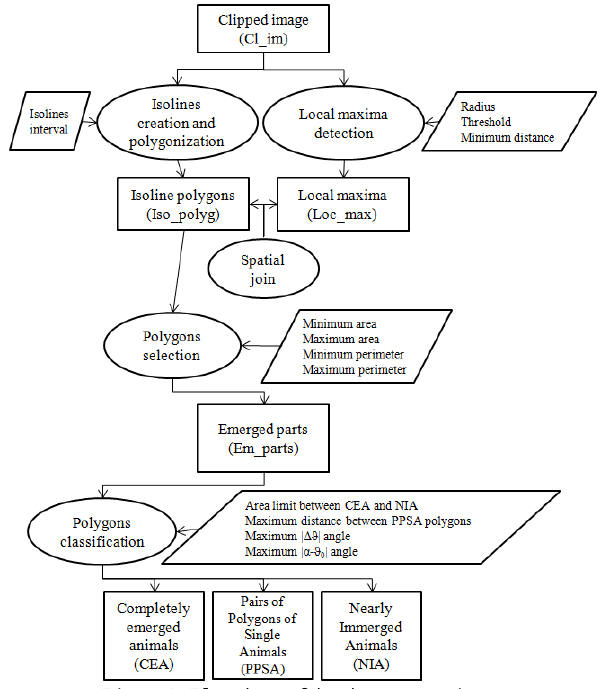
Figure 2: Flowchart of the data